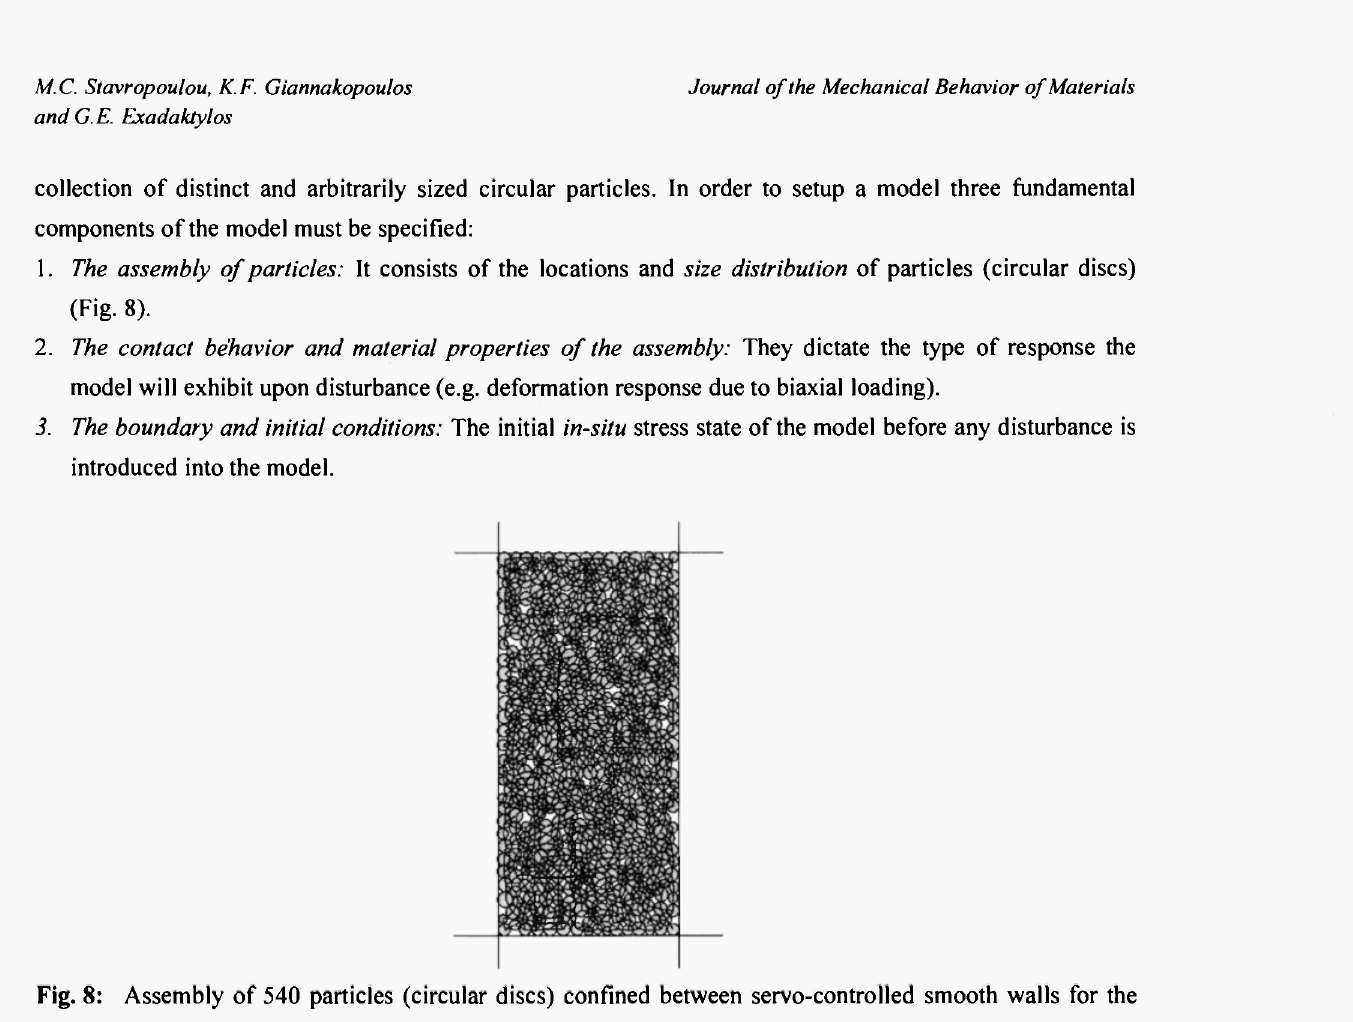
Fig. 8: Assembly of 540 particles (circular discs) confined between servo-controlled smooth walls for the simulation of a biaxial test and bonds (lines) between the